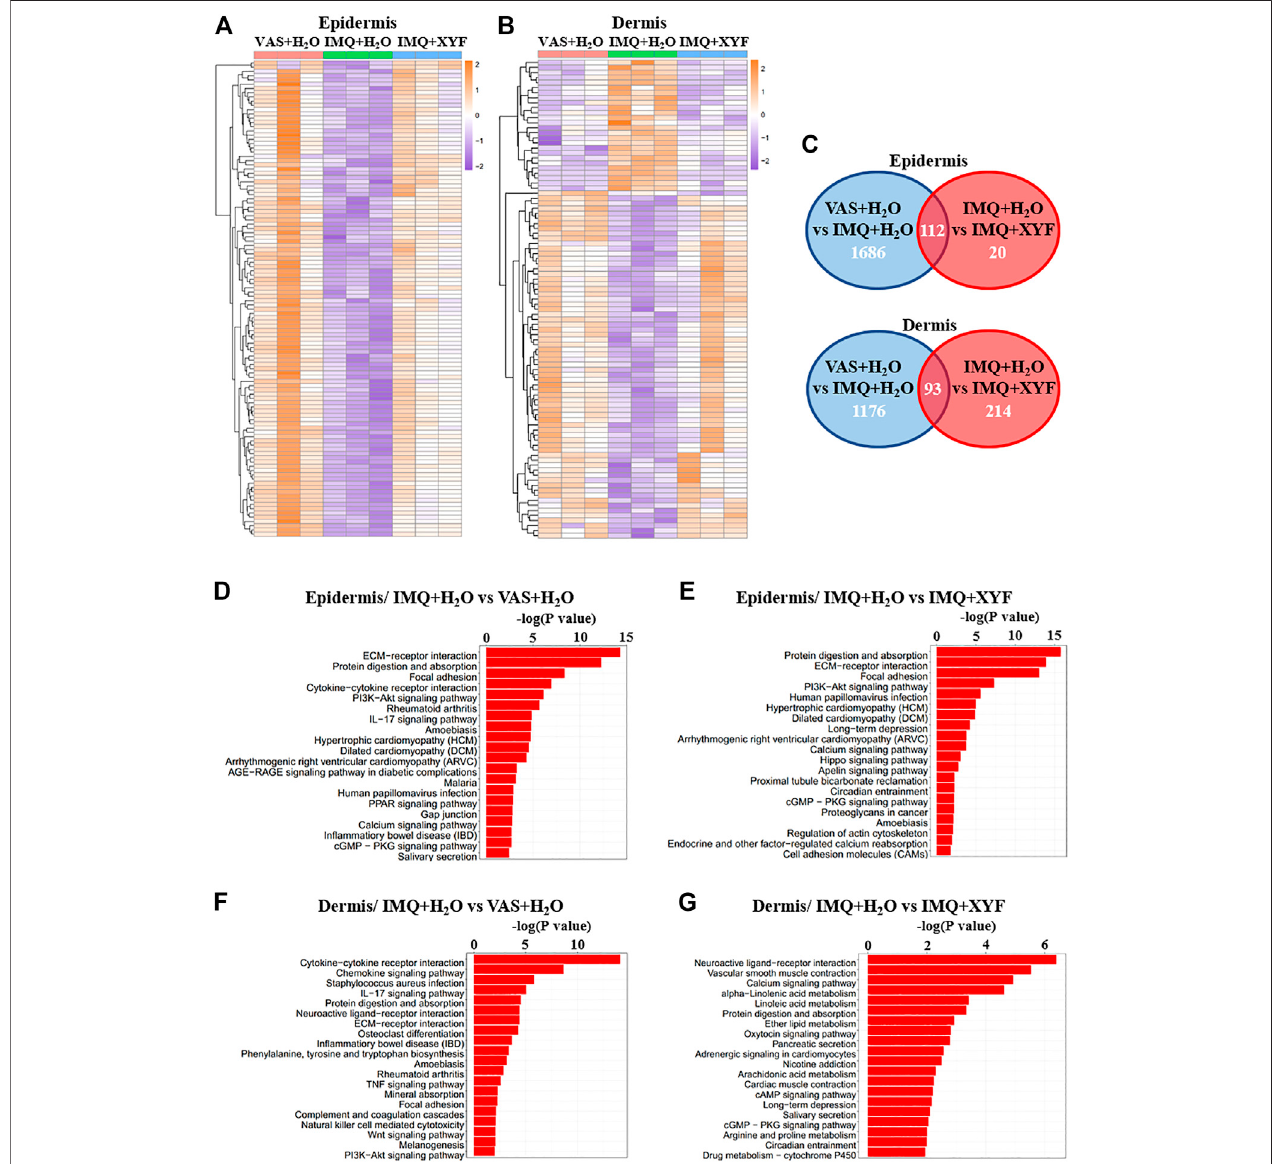
FIGURE 7 | Transcriptional analysis of Xiao-Yin-Fang therapeutic effects. Epidermal and dermal sheets of mouse ears were freshly obtained from VAS + H 2 O, IMQ + H 2 O and IMQ + XYF group ( n (cid:2) 3 for each group), which underwent RNA sequencing analysis. (A, B) Heatmap clustering analysis of epidermal and dermal differentially expressed genes (DEG). (C) Venn diagrams showed the numbers of overlapping epidermal DEGs (upper panel) and dermal DEGs (lower panel) between VAS + H 2 O vs. IMQ + H 2 O and IMQ + H 2 O vs. IMQ + XYF. (D-G) KEGG pathway analysis of